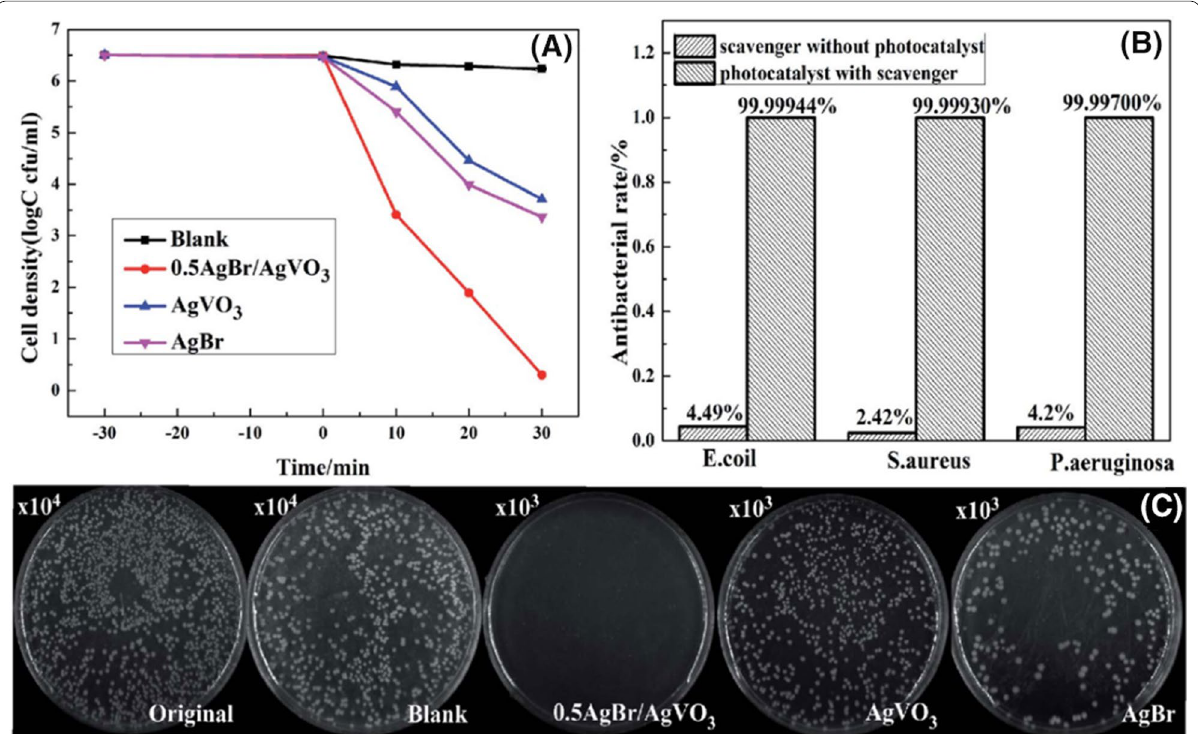
Fig. 11 A P. aeruginosa survival curves in the antibacterial experiments, B photocatalytic antibacterial rates of E. coli , S. aureus and P. aeruginosa with 0.5AgBr/AgVO 3 for 30 min, and the survival pictures of P. aeruginosa colonies in the presence of different photocatalysts. C Copyright (2019). Adapted from Ref. [130] with permission. The Royal Society of